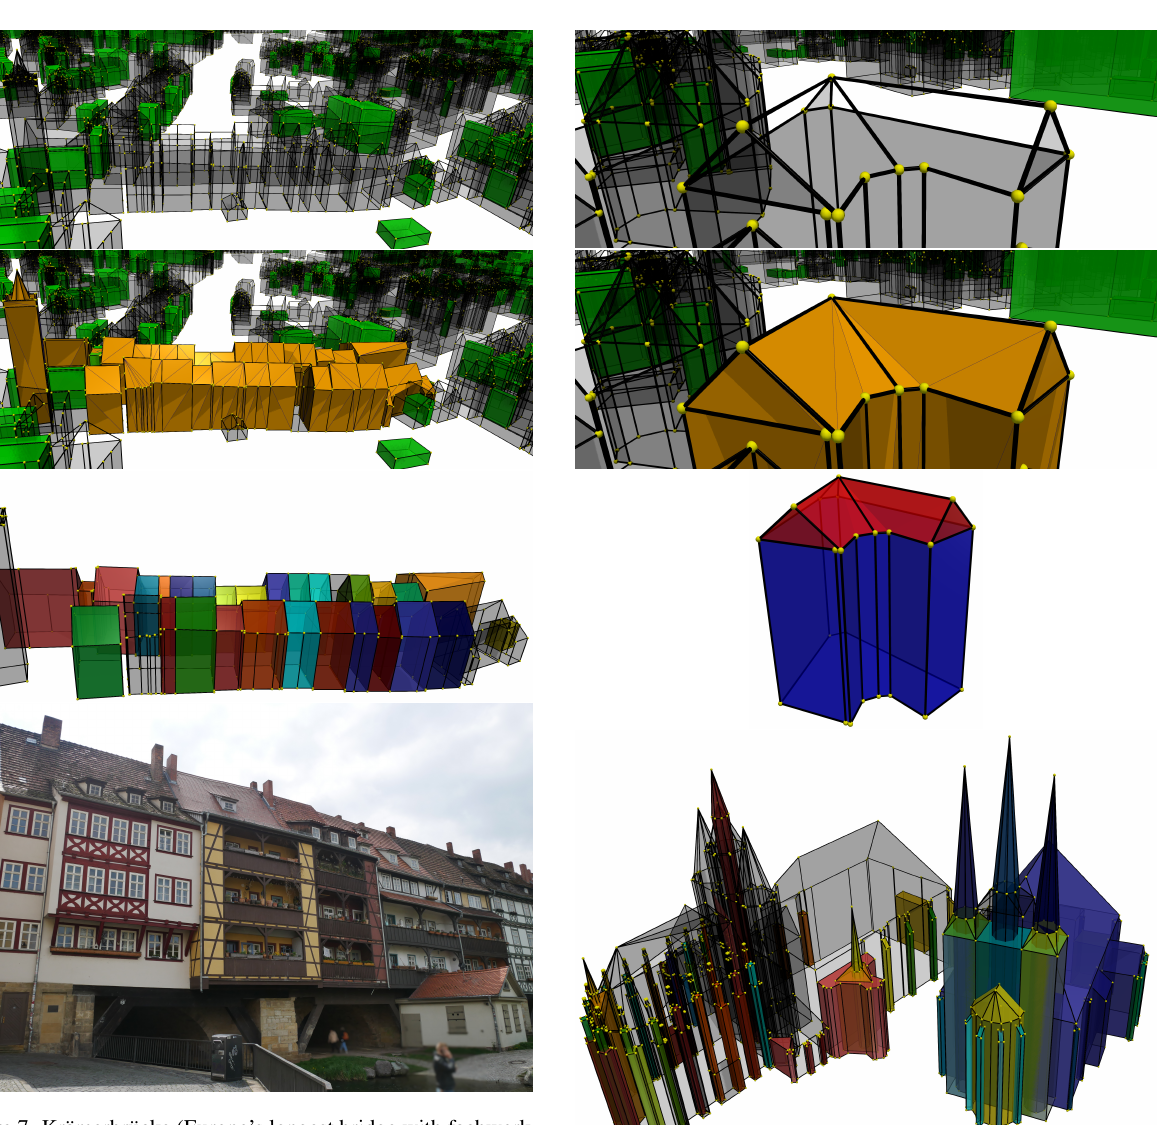
Figure 7. Kr¨amerbr¨ucke (Europe’s longest bridge with fachwerk houses on both sides), CityGML wireframe (black), triangle complexes (grey) with ignored planar constraint while Figure 8. Juri-Gagarin-Ring 2 (top three), Erfurter Dom & triangulation (orange), tetrahedron complexes (green) with Severikirche (bottom), CityGML wireframe (black), triangle splitting of non-planar triangle complexes as pre-processing step complexes (grey) with ignored planar constraint while (coloured) triangulation (orange), tetrahedron complexes